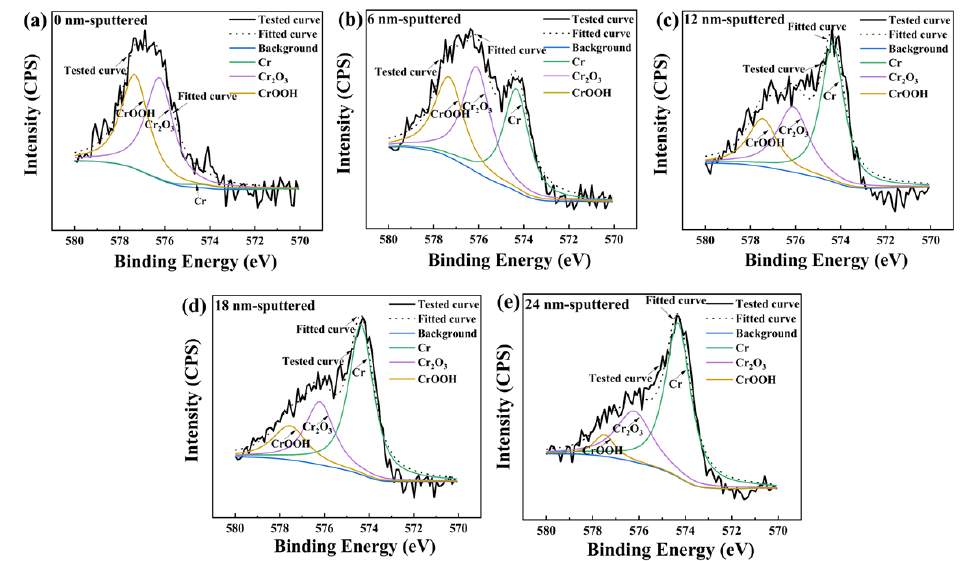
Figure 7. XPS depth analysis of Cr 2p 3/2 at ( a ) 0 nm, ( b ) 6 nm, ( c ) 12 nm, ( d ) 18 nm, and ( e ) 24 nm in the passive film of the rebar matrix.